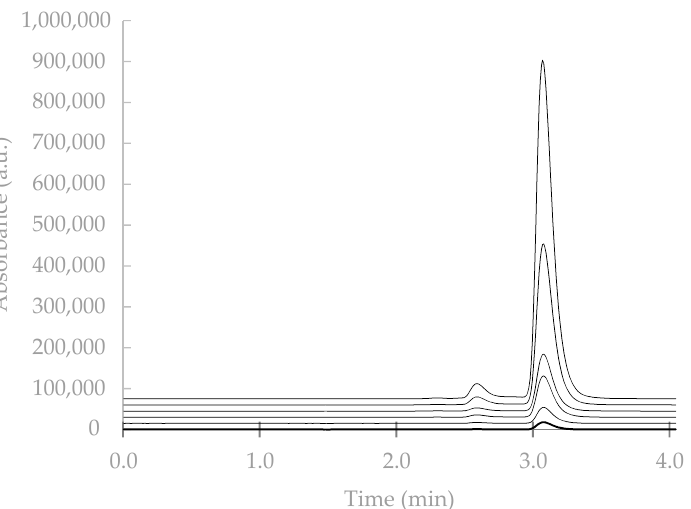
Figure 3. Typical HPLC chromatograms of blank (bold solid line, spiked with 100 µ L of PBS without Au 3+ ) and five Au 3+ quantities (plain lines, corresponding to 1.0, 2.2, 4.0, 8.0, and 10.6 nmol, from the smallest to the largest peak, respectively, obtained after spiking 100 µ L of AuNP suspension on 250 mg rat liver. Table 2. Statistical evaluation ( F -test) of linearity for the Au 3+ quantity from AuNPs added to 100 µL of rat plasma or added to 250 mg of rat liver (five quantities on three days) with a linear regression model. Linear Model